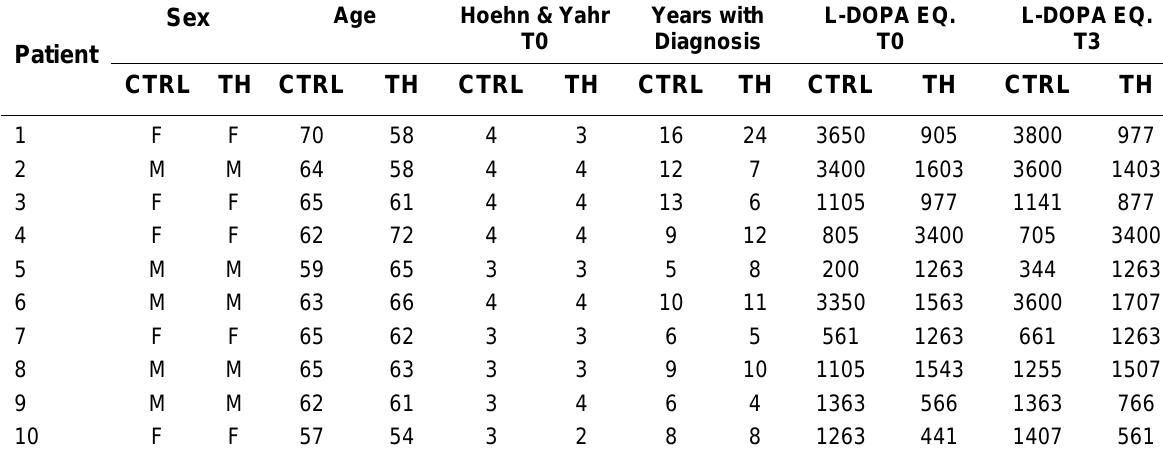
Clinical Data of Patients Affected by PD of Control (CTRL) and Theater (TH)